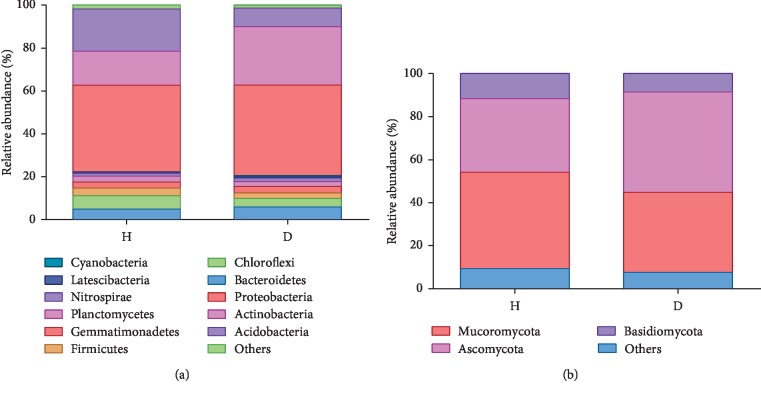
Taxonomic classification at the phylum level of bacterial (a) and fungal (b) reads retrieved from healthy and rusty root-affected Panax ginseng. The bar marked “Others” represents the relative abundance of all phyla not specifically listed. All values are presented as means ± SE (n = 3). H: healthy plants; D: diseased plants.